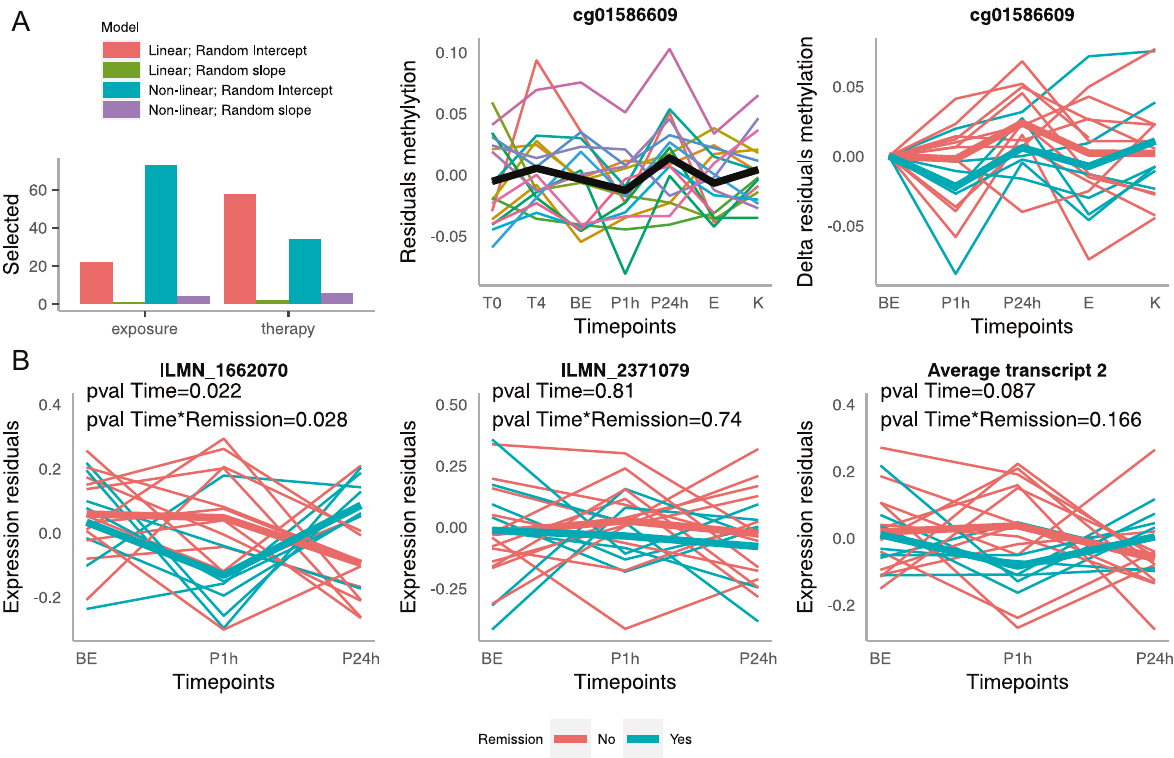
Fig. 3 Regulation of HTR3A methylation and gene expression during the exposure phase. A Methylation: Left: Distribution of the selected models among the 100 best sum-ranked CpGs in the exposure and therapy phase. Middle: Evolution over time of cg cg01586609 ’ s methylation residuals after regressing out the immune cell-type composition (referred as methylation residuals later) during the therapy (T0, T4, E, K) and exposure (BE, P1h, P24h) timepoints. The thick black line represents the mean over all samples. Right: Evolution over the exposure timepoints and subsequent therapy timepoints of the methylation residuals, centered at the value observed 1h before exposure. This graph represents the absolute changes in methylation during exposure, independent of the actual methylation levels. Thicker lines represent the mean for the remitters (blue) and non-remitters (red). B Gene Expression: Evolution over the therapy time points of the residuals of the gene expression data after regressing out the immune cell-types proportions of the ILMN_1662070 (left) and ILMN_2371079 (middle) probes annotated to the HTR3A gene and their average (right). Thicker lines represent the mean for the remitters (blue) and non-remitters